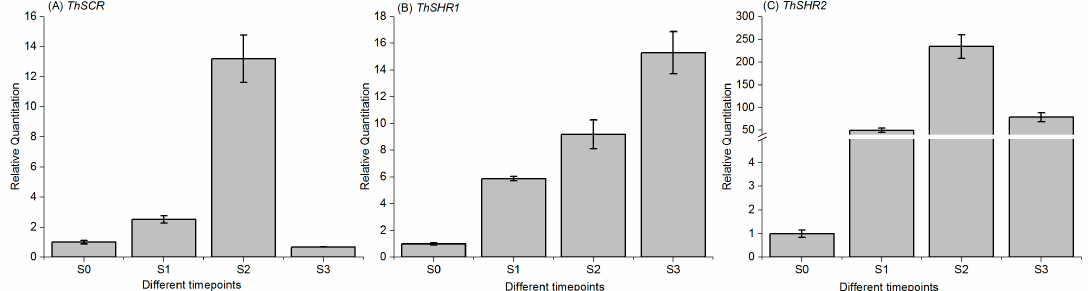
Figure 5. Temporal expression patterns of ThSHR1 , ThSHR2 and ThSCR by real-time PCR. S0, S1, S2 and S3 are the tissues at 0 day, initial formation of callus, primary root and the lateral roots, respectively. For real-time PCR, adenine phosphoribosyl transferase ( APRT) was used as the internal control, and the relative transcript levels were calculated using the comparative delta-Ct method. Error bars represent the standard deviation for each sample, based on three biological replicates (the averages of technical replicates).